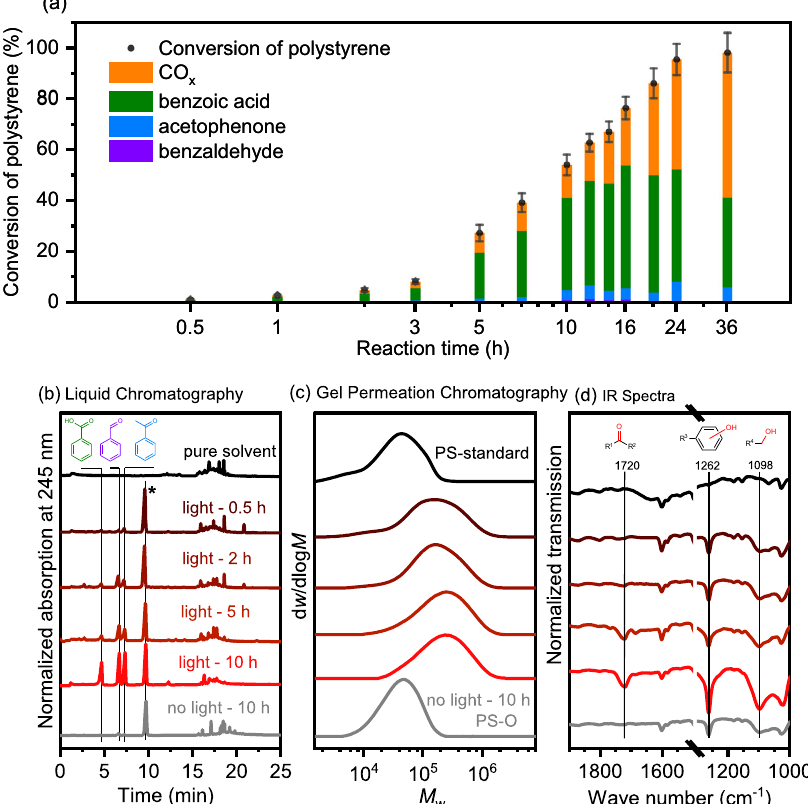
Fig. 1 | Analysis of product and PSreactant indifferent reactionstages. a Time- evolutionofdifferentproductsforpolystyrenephotocatalyticoxidationreactionat 150°C under 10bar O 2 , 50mg g-C 3 N 4 , 10mg polystyrene ( M w ~50kDa), 30mL acetonitrile, 300W Xenon lamp. Distribution of different products are shown by column with different colors. The error bars represent the standard deviation of conversionin3parallelexperiments. b Liquidchromatogramsofreactionsolutions withdifferenttimeandconditions.The fi rstlinepuresolventreferstothe signalof